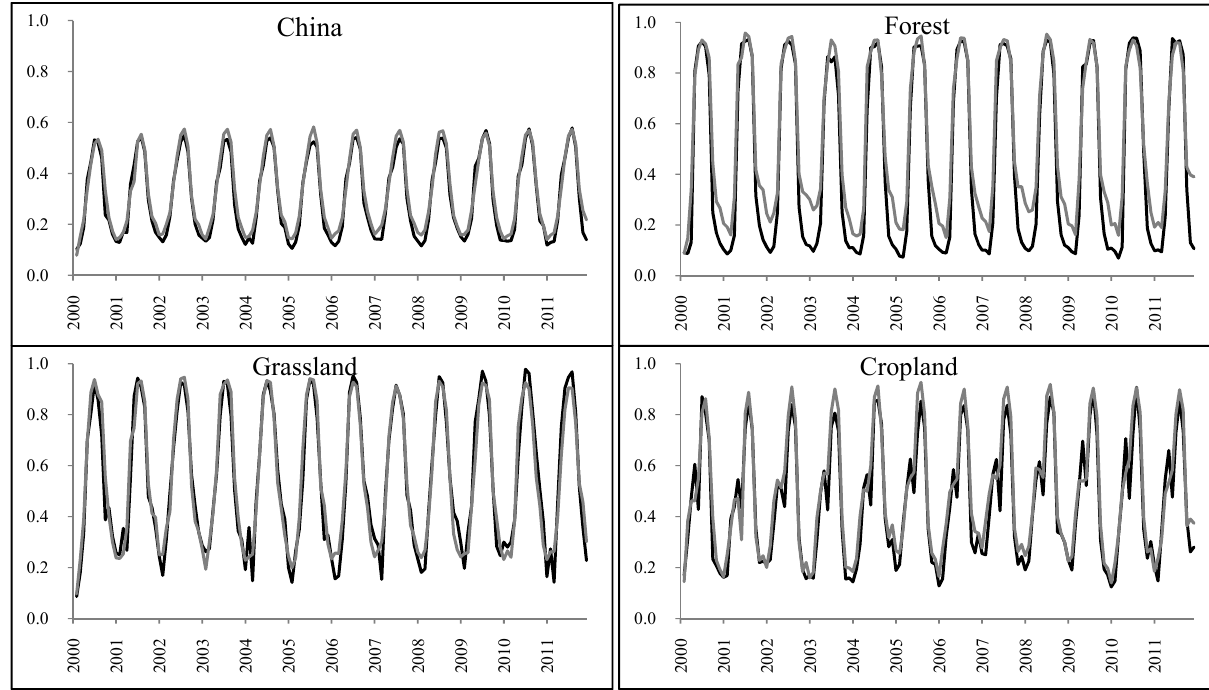
Figure 1. Time series of monthly GIMMS and MODIS fractional vegetation cover (FVC) (2000–2011) for selected regions. GIMMS time series FVC is depicted in black and MODIS FVC in